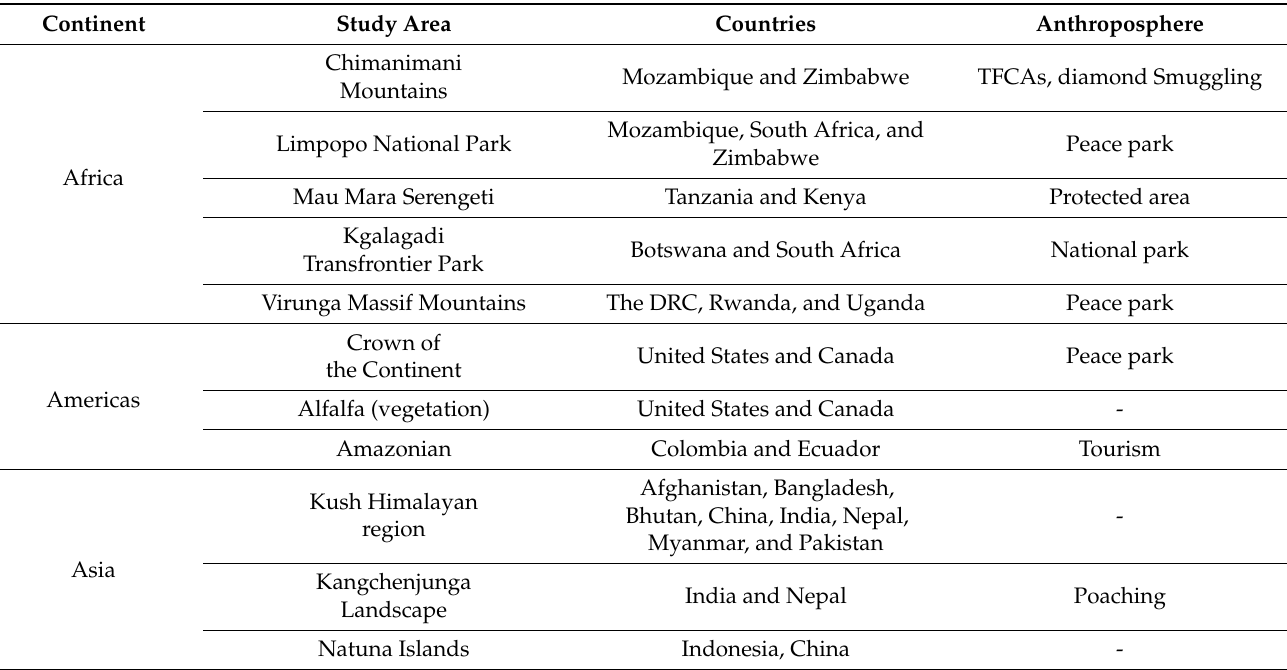
Table 7. The natural resource conflict cases related to the